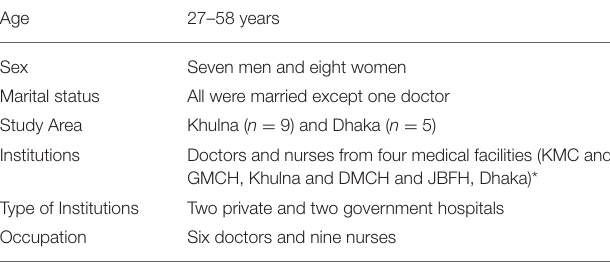
TABLE 1 | Sociodemographic profile of